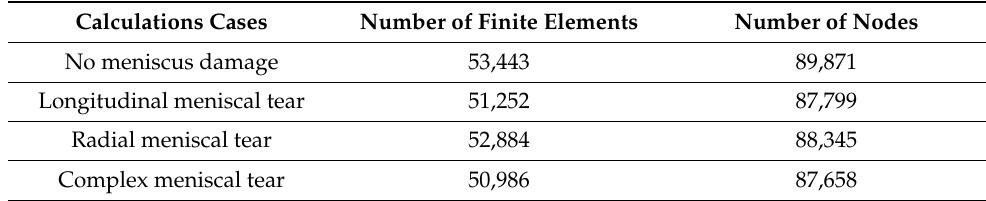
Figure 6. ( a ): Schematization of load; ( b ): Finite element mesh. Table 3. Mesh data on various model